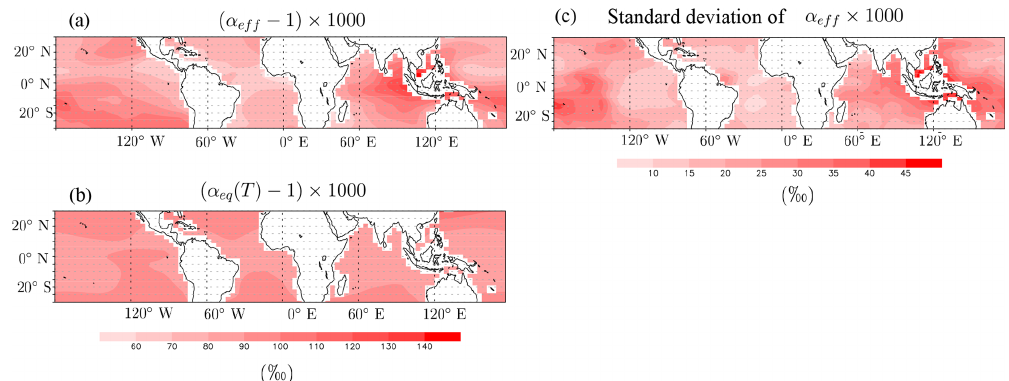
Figure D2. (a) α eff − 1, where α eff is the effective fractionation coefficient, expressed in per mill. (b) α eq (T ) − 1 expressed in per mill. All daily values are averaged over all days in winters of all years. (c) Standard deviation of α eff among all days in winter of all years, expressed in per